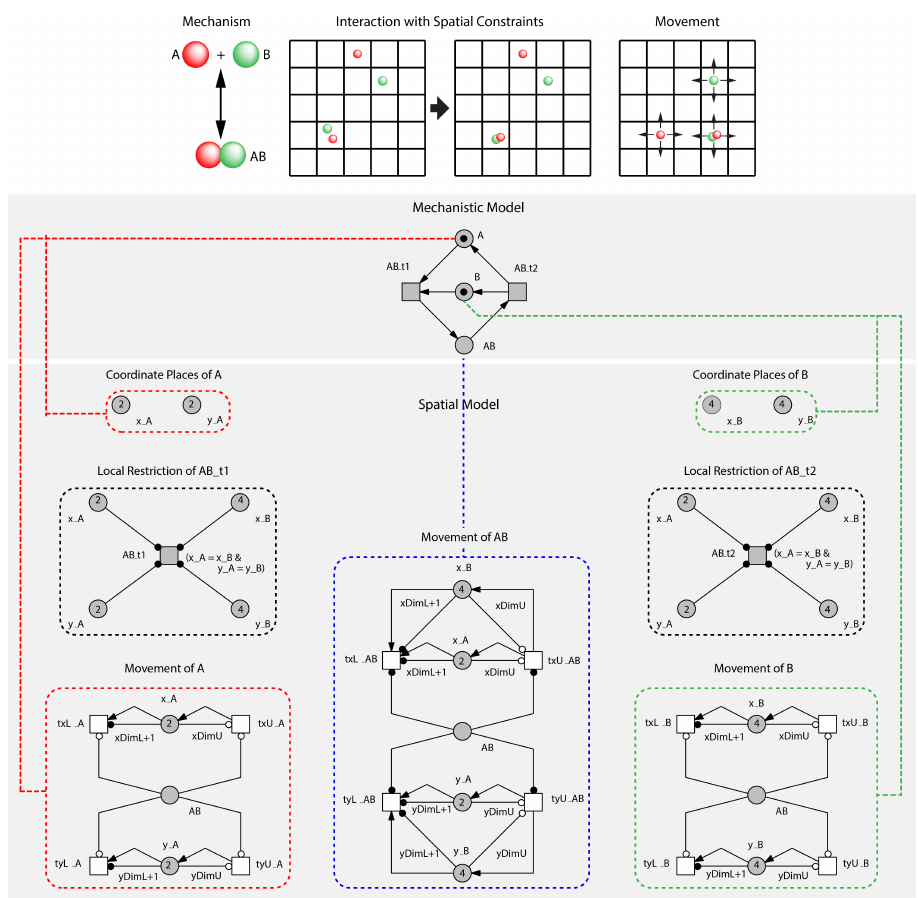
Figure 4: Basics of the spatial transformation concept. Running